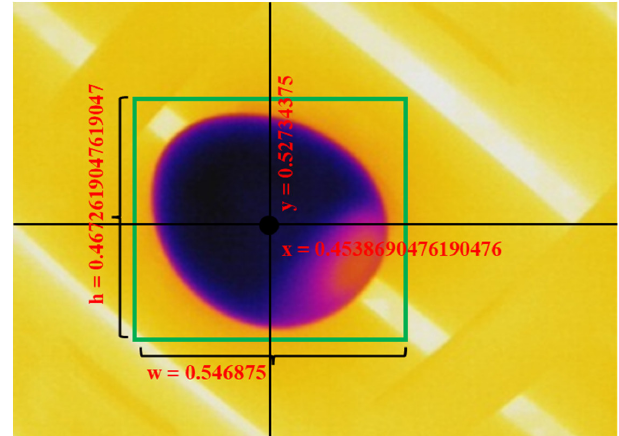
Figure 7. Image labeling for YOLO format. The coordinates x and y represent the position of the center point of the object in relation to the figure in pixels. H and W are the sizes of the bounding boxes in pixels.